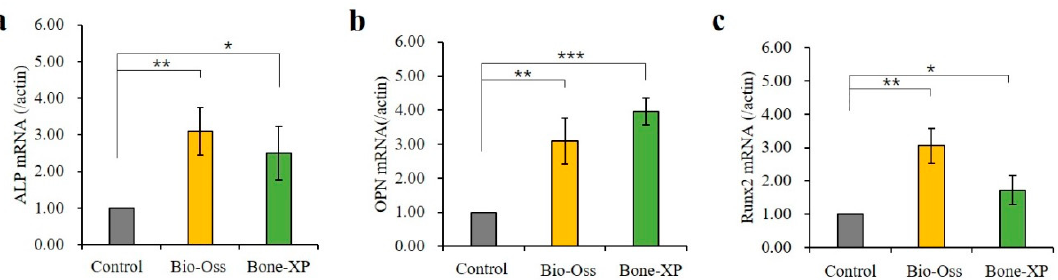
Figure 7. Real-time polymerase chain reaction (PCR) analysis of hMSCs on extracts. ( a ) ALP , ( b ) OPN, and ( c ) RUNX2 were selected as the osteogenic differentiation related genes. The symbol * indicates statistical significance compare to control group (* p < 0.05, ** p < 0.01, *** p < 0.001).